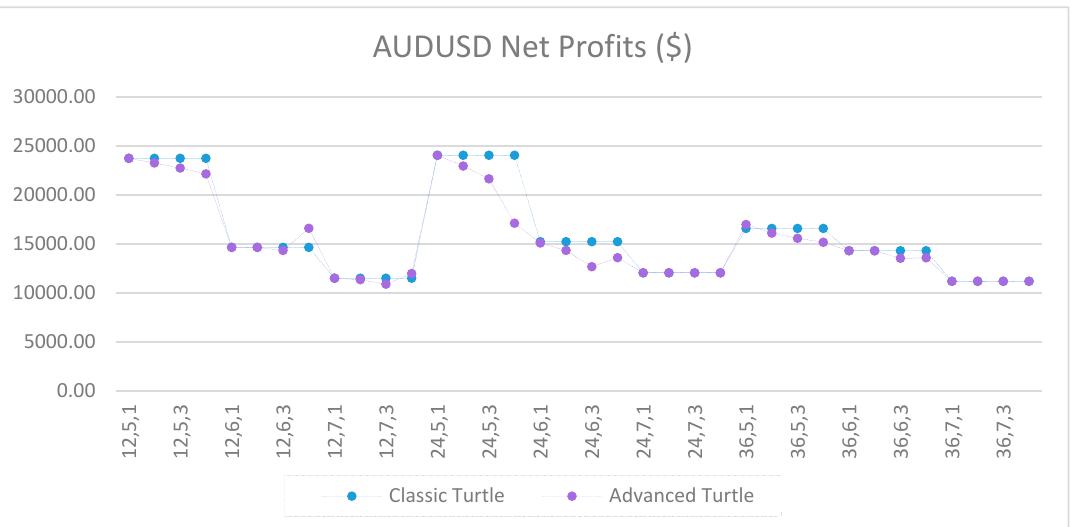
Figure A49. Net profits of BTCUSD between the classic and the advanced Turtle systems for every combination of N, X, Y for the slow parameters (80, 160), where X ≥ 5.